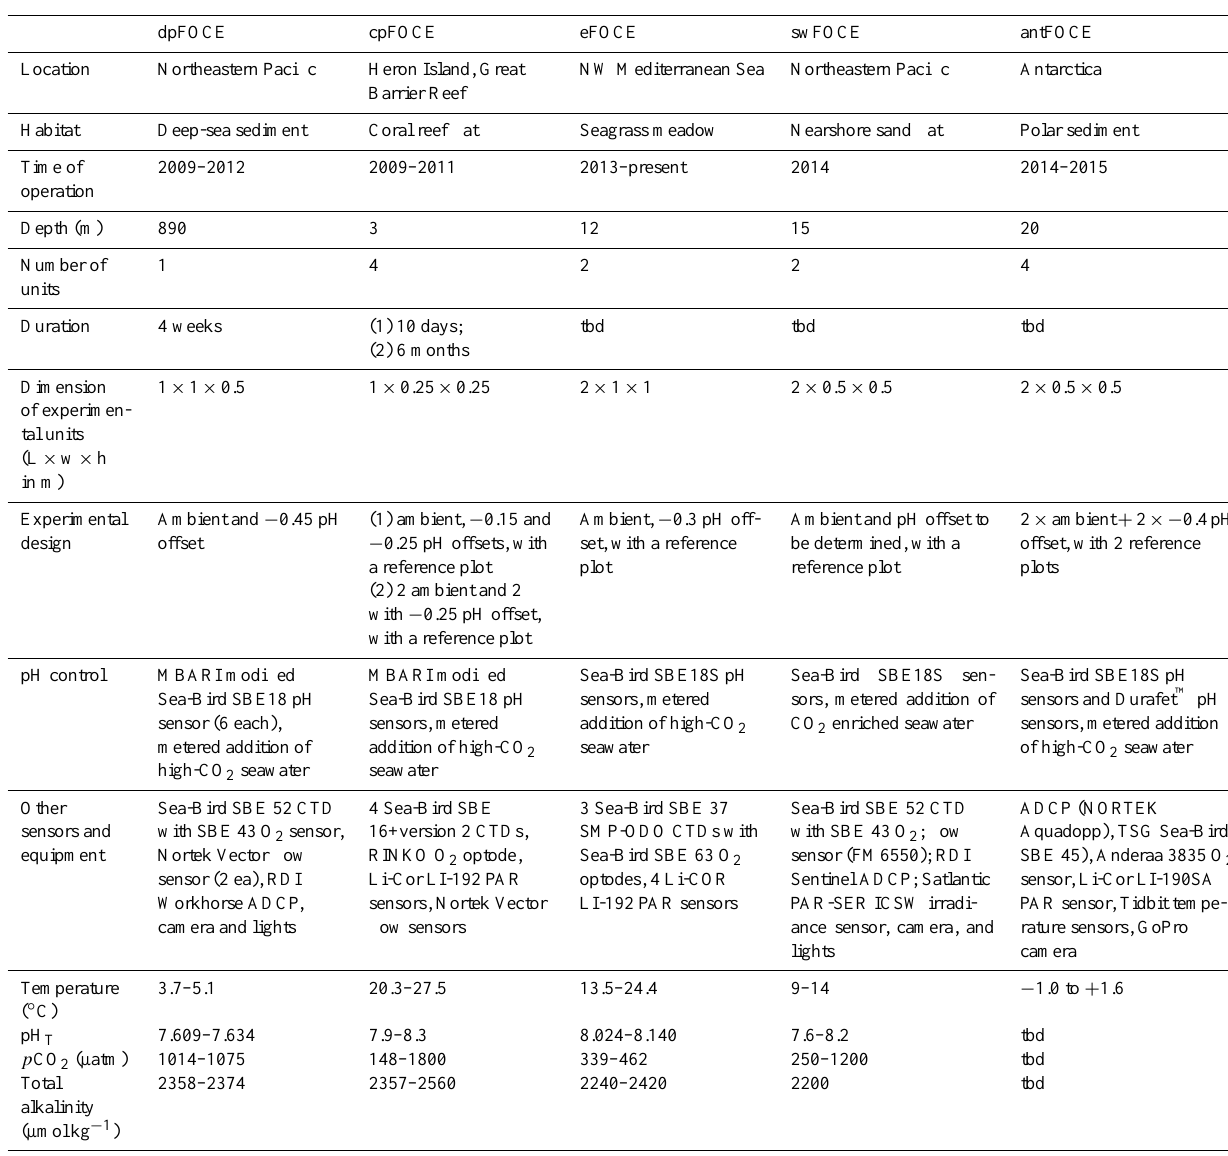
Table 1. Design of past, current, and planned FOCE systems. tbd: to be determined.